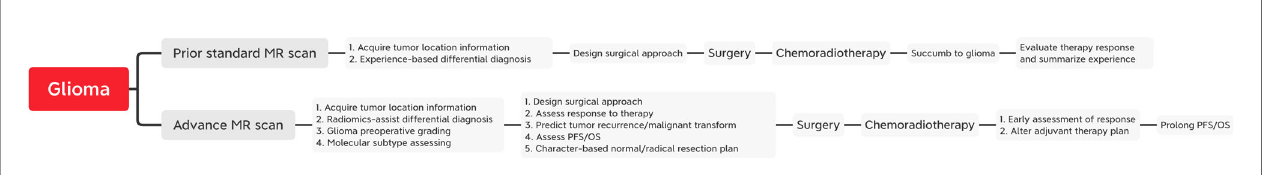
FIGURE 2 | Glioma clinical practice fl ow under standard MR scan and advance